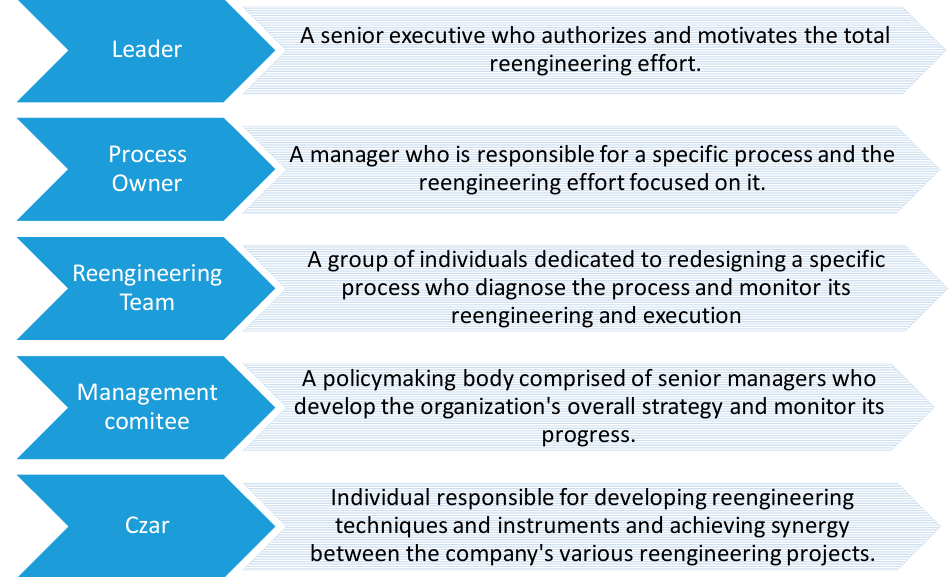
Figure 3. Characteristics of the roles in reengineering elaborated by the authors, according to Hammer and Champy [1].